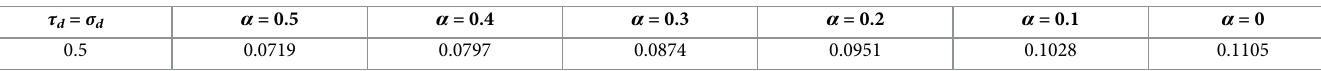
, σ and α of Example 5. d d